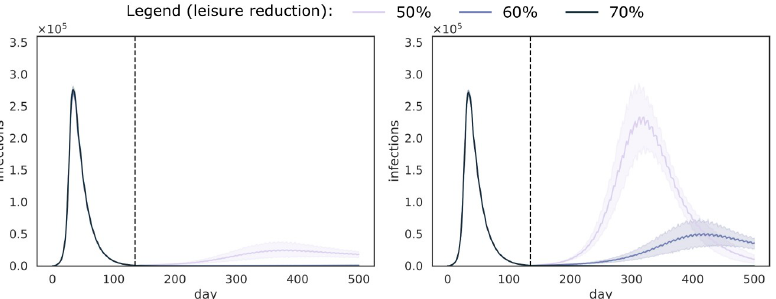
Fig 4. Trends for different leisure contact reductions, when performing weekly universal testing. We assume that universal testing starts (and lock-down ends) on the first of July, as marked by the vertical dotted line, and that FNR PCR = 0.1. We consider both isolation strategies: pool isolation (left panel) and individual isolation (right panel). The curves show a line that depicts the average over the trajectories of the result aggregations and a shaded area that depicts the standard